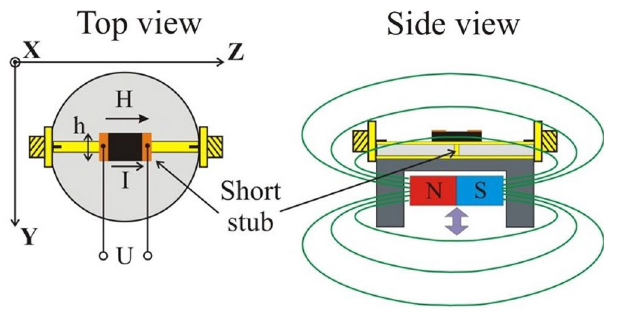
Figure 1. Schematics of the ferrite-based band-pass filter prototype showing the position of Zn 2 Y resonator on top of the short-circuited microstrip line and a permanent magnet located inside the filter frame to apply a bias magnetic